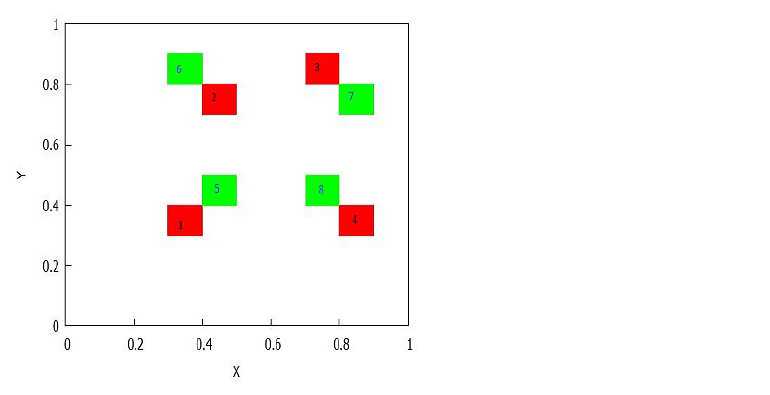
Figure 35. Here, ω F ( x , y ) = W 1 ∪ W 2 , with W 1 = ω F 2 ( x , y ) (in red color) and W 2 = ω F 2 ( F ( x , y )) (in green color); the movement of the orbit by F is 1 → 2 → 3 → 4 → 5 → 6 → 7 → 8; see also Figure 17.